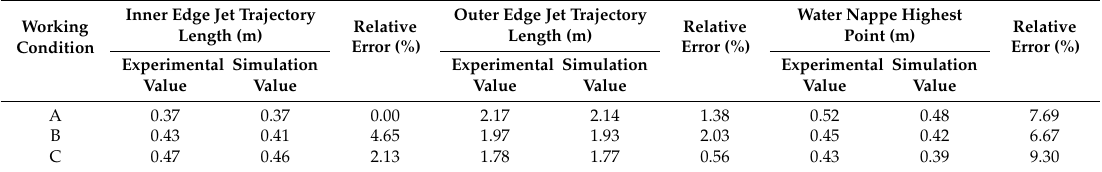
Table 3. Comparison of the experimental and simulation results with a swallow-tailed bucket.